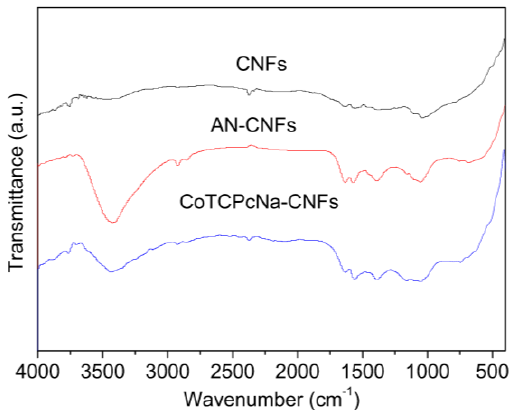
Figure 1. Fourier transform infrared spectroscopy (FT-IR) for carbon nanofibers